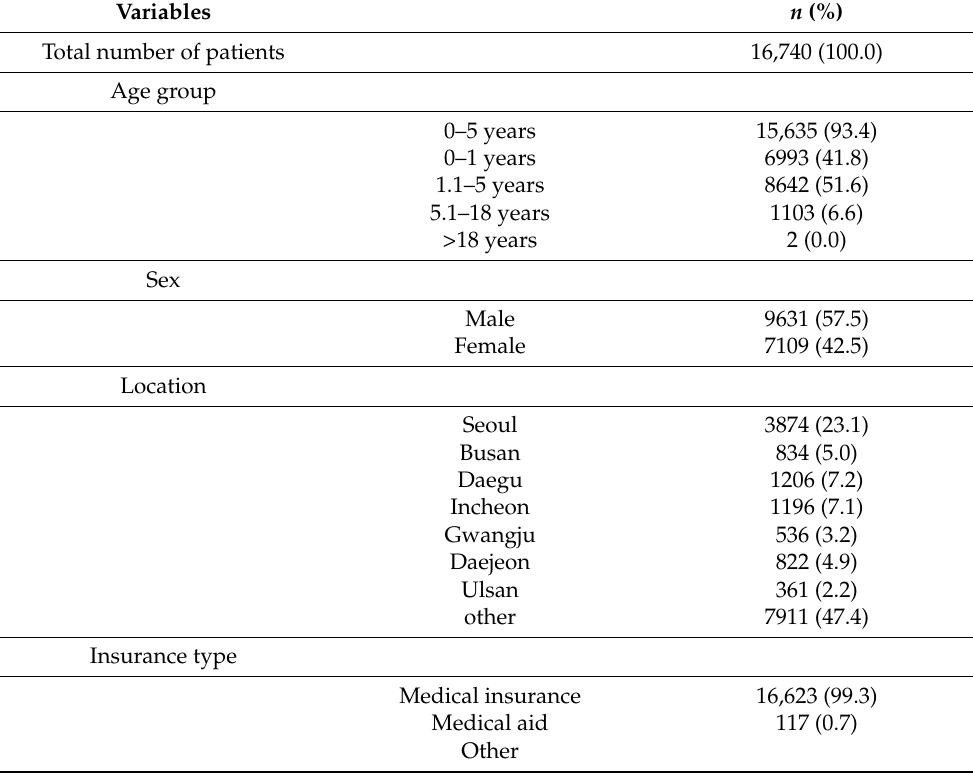
Table 1. Characteristics of patients.